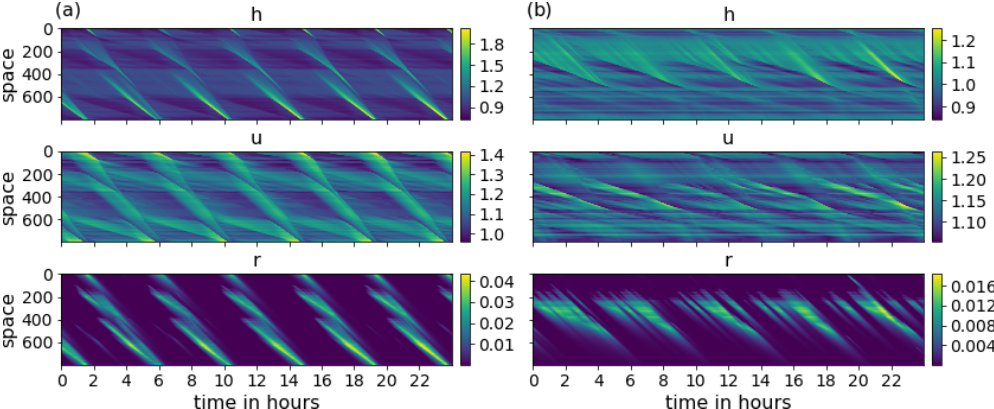
Figure 1. A 24h segment of the HR simulation for the three model variables h , u , and r (from top to bottom), corresponding to the regular case (a) and the chaotic case (b) .